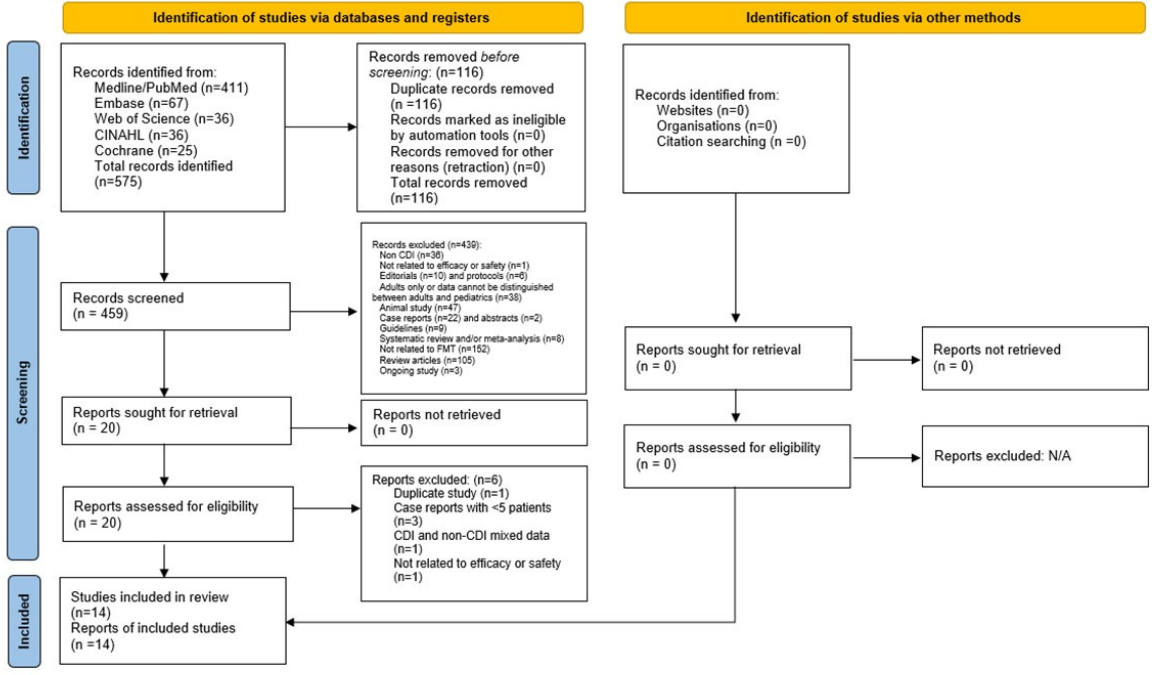
Figure 1. Preferred reporting items for systematic review and